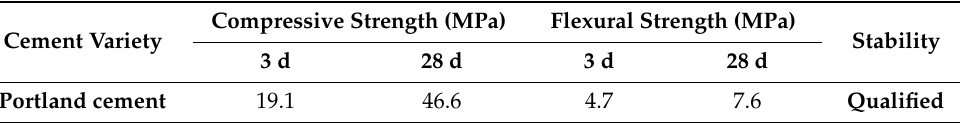
Figure 2. Fluidity and water requirement ratio (WRR) test process of RP. Table 3. Basic performance index of cement.